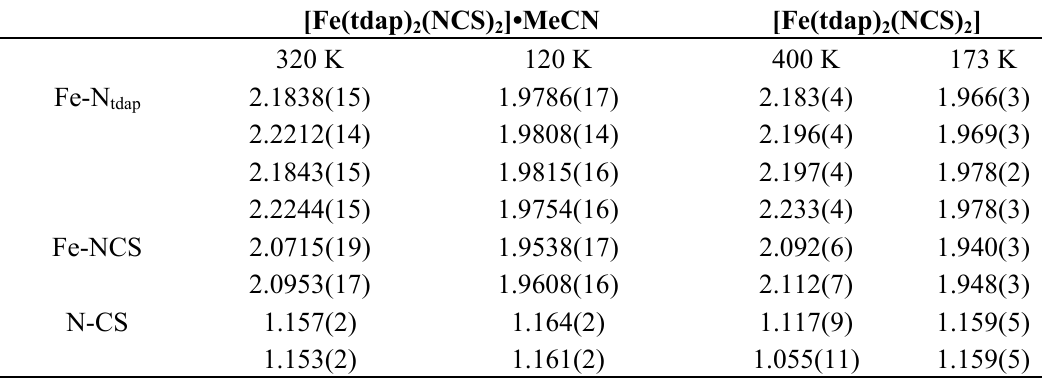
(NCS) ]•MeCN and [Fe(tdap) 2 2